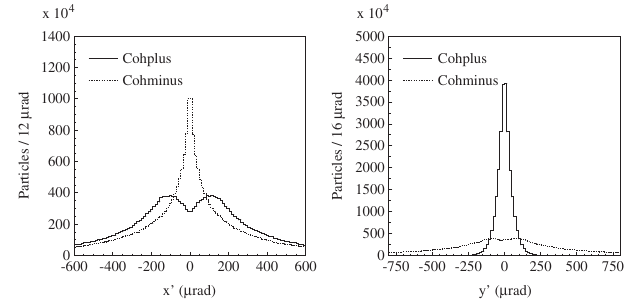
FIG. 6. Relative energy spectrum of the electrons and posi- trons coming from the radiative Bhabha scattering (full line) and from the incoherent pair production (dashed line). This plot shows the amount of particles per bunch